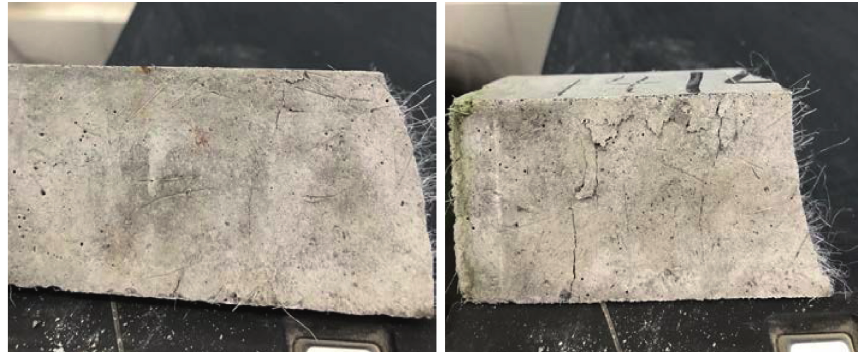
Figure 5: Specimen appearance after compressive failure.